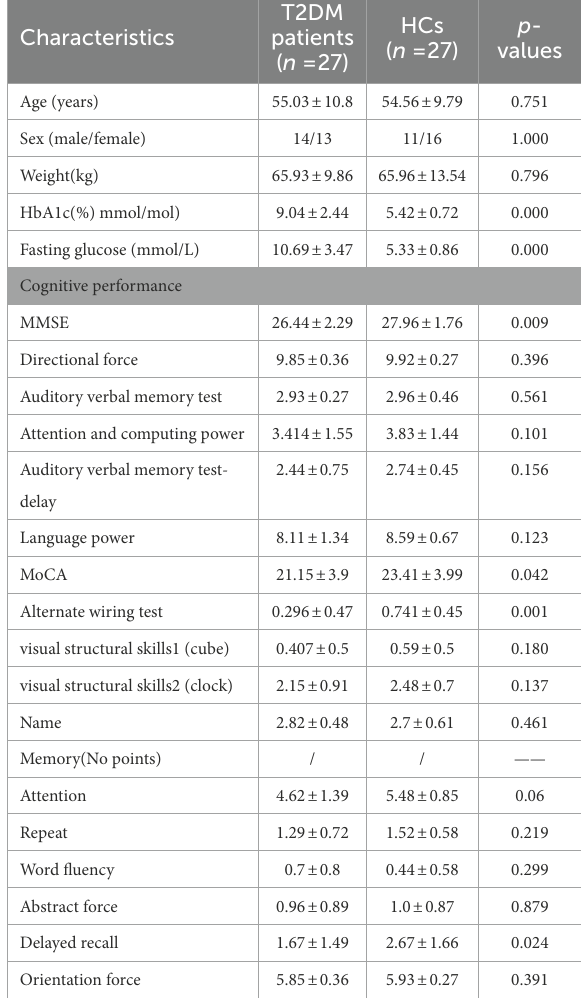
TABLE 1 Demographic and clinical characteristics with T2DM and healthy